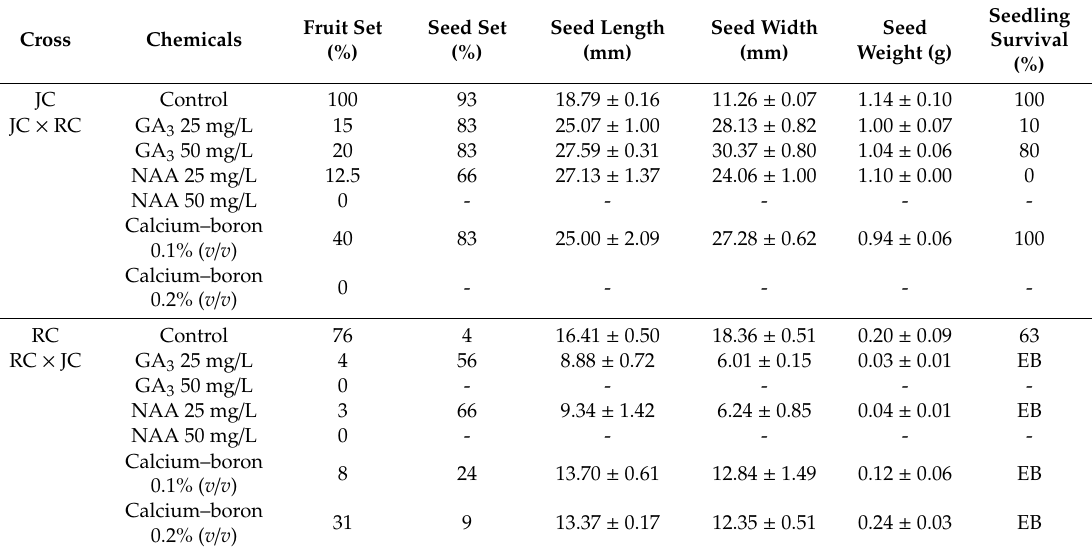
Table 1. E ff ect of GA 3 , NAA, and calcium–boron on sexual intergeneric